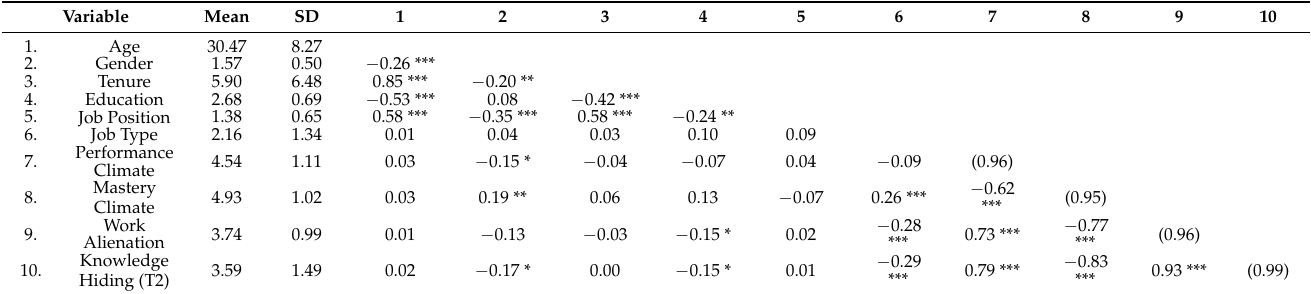
Table 1. Descriptive Statistics and Correlations.